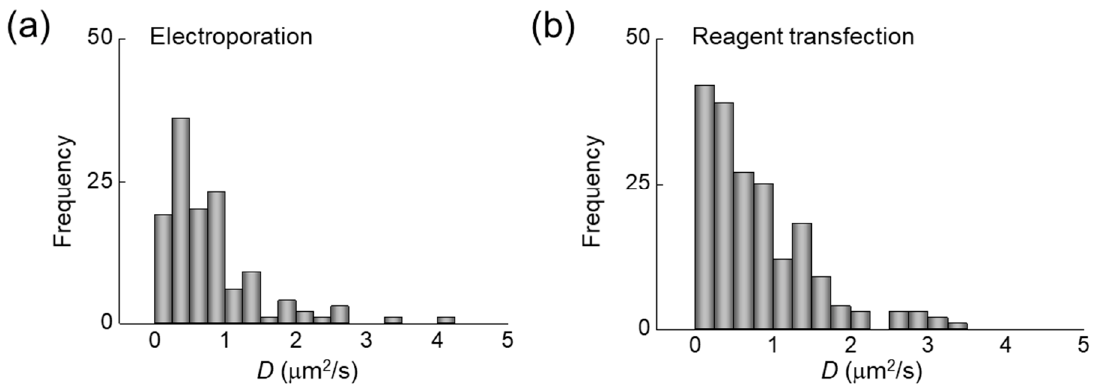
Figure 5. Summary of measured diffusion coefficient D values of the D 514 probe in live HeLa cells ( n = 15). The histograms show D values for the D 514 probe in HeLa cells after ( a ) electroporation and ( b ) transient transfection using a reagent. For simplicity, only the diffusion coefficient of the slow component is shown. Table 1. Comparison of mean diffusion coefficients D of the D 514 probe and GFP in medium and in HeLa cells.